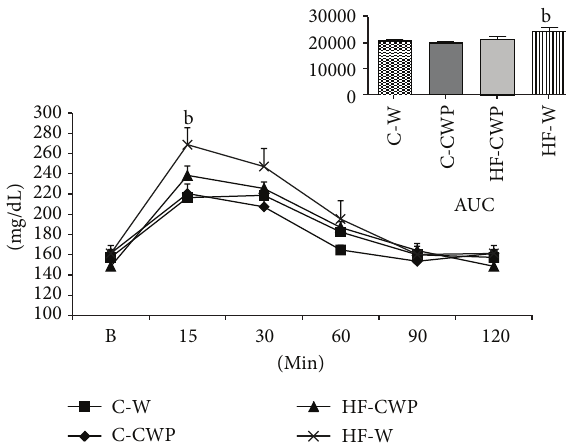
Figure 3: OGTT and AUC (area under the curve) after eight weeks of treatment with high fat diet (HF) or normocaloric control (C) associated with gavage of coacervate (CWP) or water (W). Glycemia in time zero (basal-B), 15, 30, 60, 90, and 120 minutes after gavage of 0.2 g/100 g body weight of glucose. Data submitted with an average ± EPM. (b) C-W versus HF-W. ( 𝑃 < 0.05